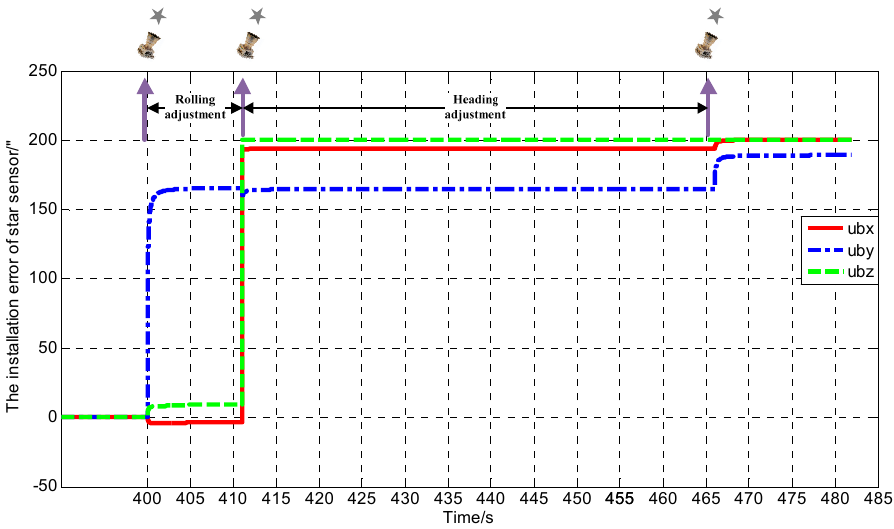
Figure 3. The installation error convergence curve for Case 3.